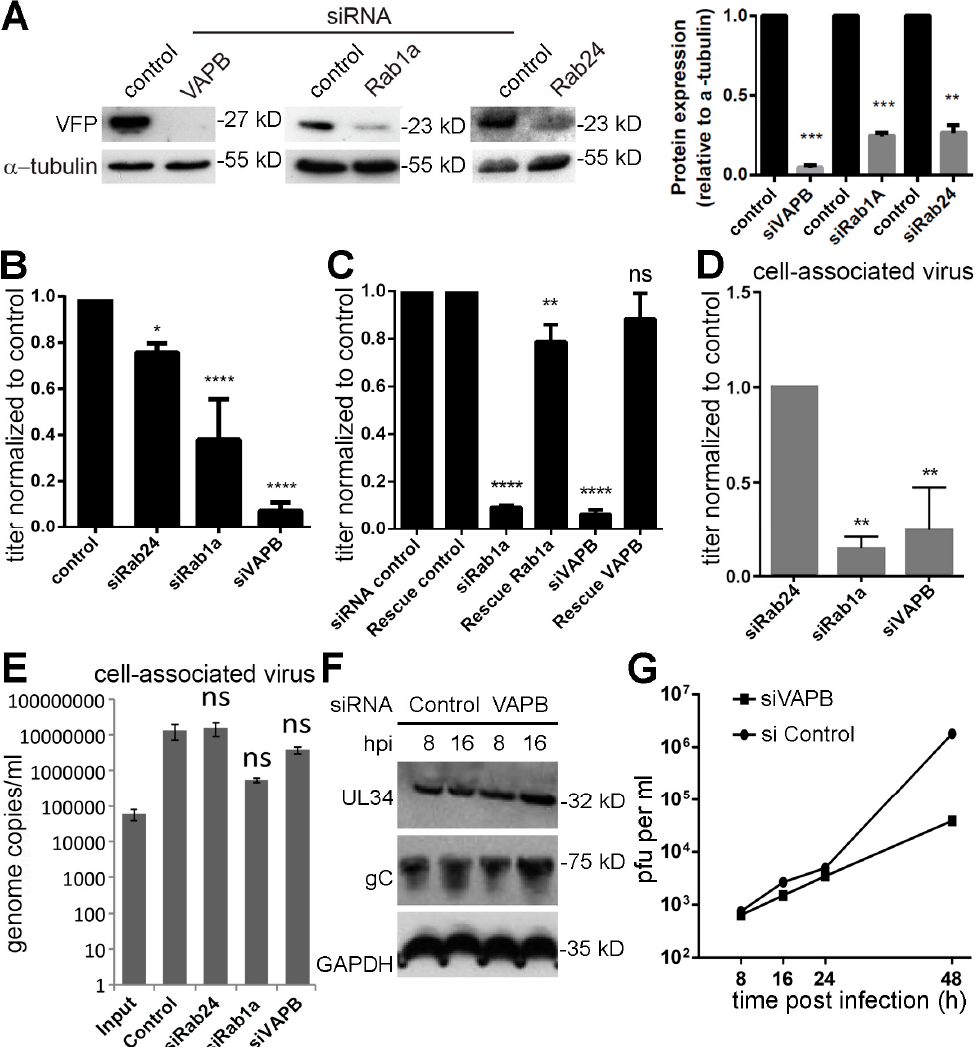
Figure 4. VAPB knockdown inhibits HSV ‐ 1 infection. ( A ) HeLa cells were transfected with siRNA oligos for VAPB and controls and cells lysed after 48 h. Western blot confirmed knockdowns. Quantification from three experiments is given in the right panel: error bars are to the standard deviation and the p ‐ values using a one ‐ way ANOVA and multiple comparisons by Dunnett's test for comparing each condition with the control are shown (** p ≤ 0.01; *** p ≤ 0.001; **** p ≤ 0.0001) . ( B ) HeLa cells were transfected with the control, Rab24, Rab1a, or VAPB siRNAs. After 48 h, cells were infected with HSV ‐ 1 (MOI = 10) and supernatant virions were collected at 16 hpi. Titers were established on U2OS cells and bars represent the average of three independent experiments, normalized to the control siRNA. Error bars are to the standard deviation and the p ‐ values using a one ‐ way ANOVA and multiple comparisons by Dunnett's test for comparing each condition with the control are shown (* p ≤ 0.05; **** p ≤ 0.0001). ( C ) Rescue experiments with cells expressing wild ‐ type protein resistant to the siRNAs were performed and supernatant virions also collected at 16 hpi. In all cases, the cells carrying both the rescue plasmid and the siRNAs recovered to roughly 80–90% of the control virus titers. Error bars are to the standard deviation and the p ‐ values using a one ‐ way ANOVA and multiple comparisons by Dunnett's test for comparing each condition with the control are shown (** p ≤ 0.01; **** p ≤ 0.0001). ( D ) After 48 h, HeLa cells transfected with the siRNAs were infected with HSV ‐ 1 (MOI = 10) and cell pellets collected at 16 hpi. Titers were established on U2OS cells and bars represent the average of three independent experiments, normalized to the data for Rab24 siRNA, used as a control to better parallel background knockdown effects compared to non ‐ target siRNA. Error bars are to the standard deviation from two separate experiments and the p ‐